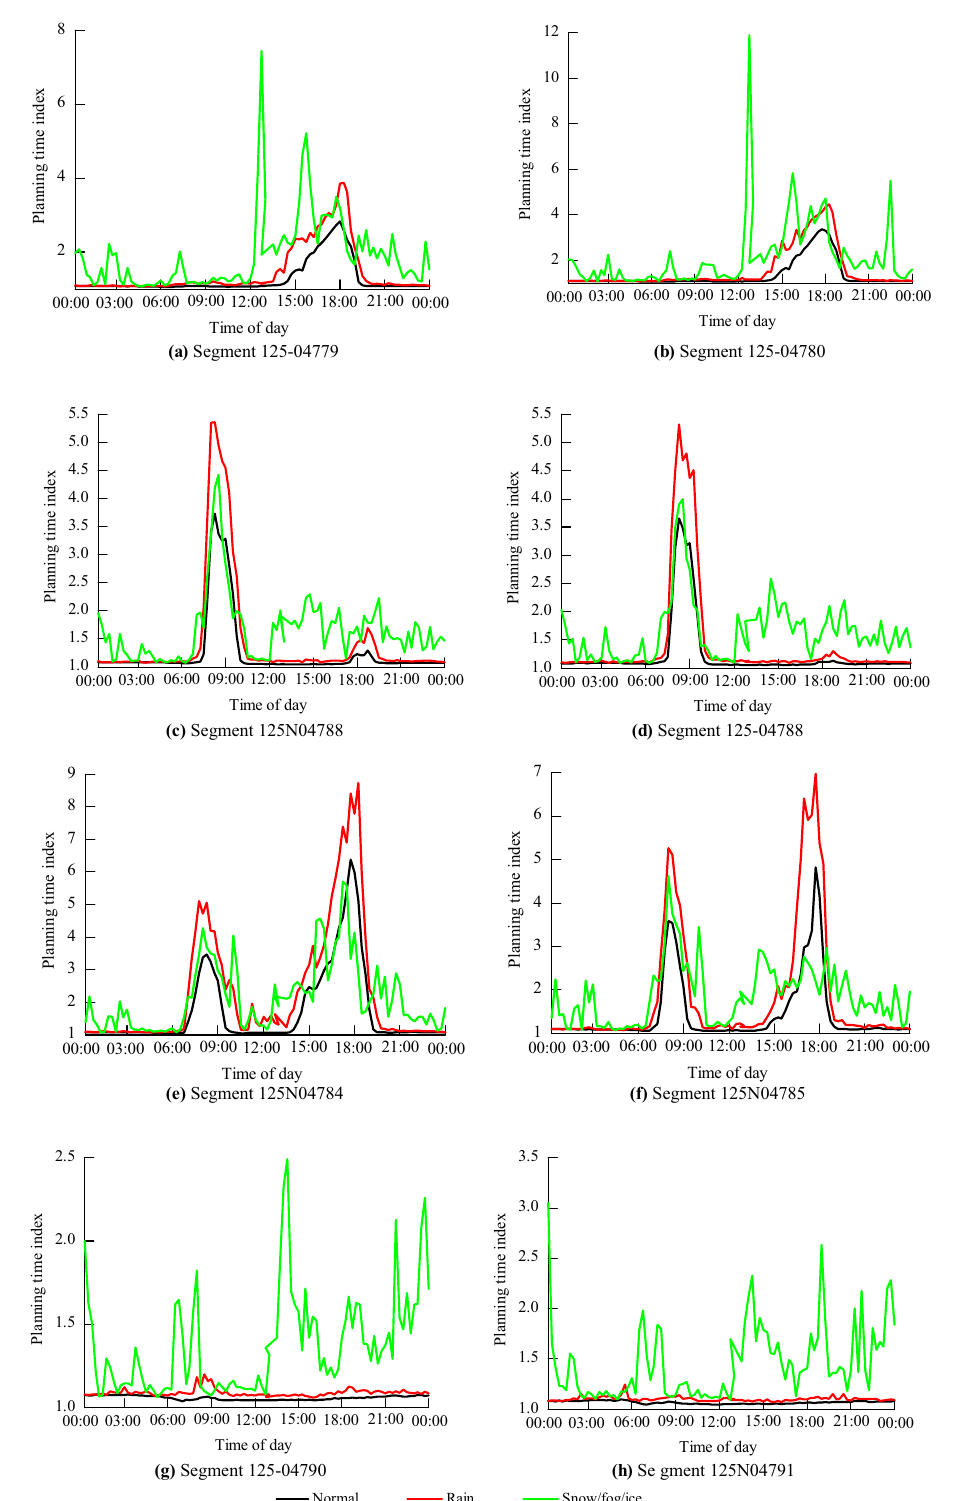
Fig. 6 TTR variability pattern of each segment under different weather